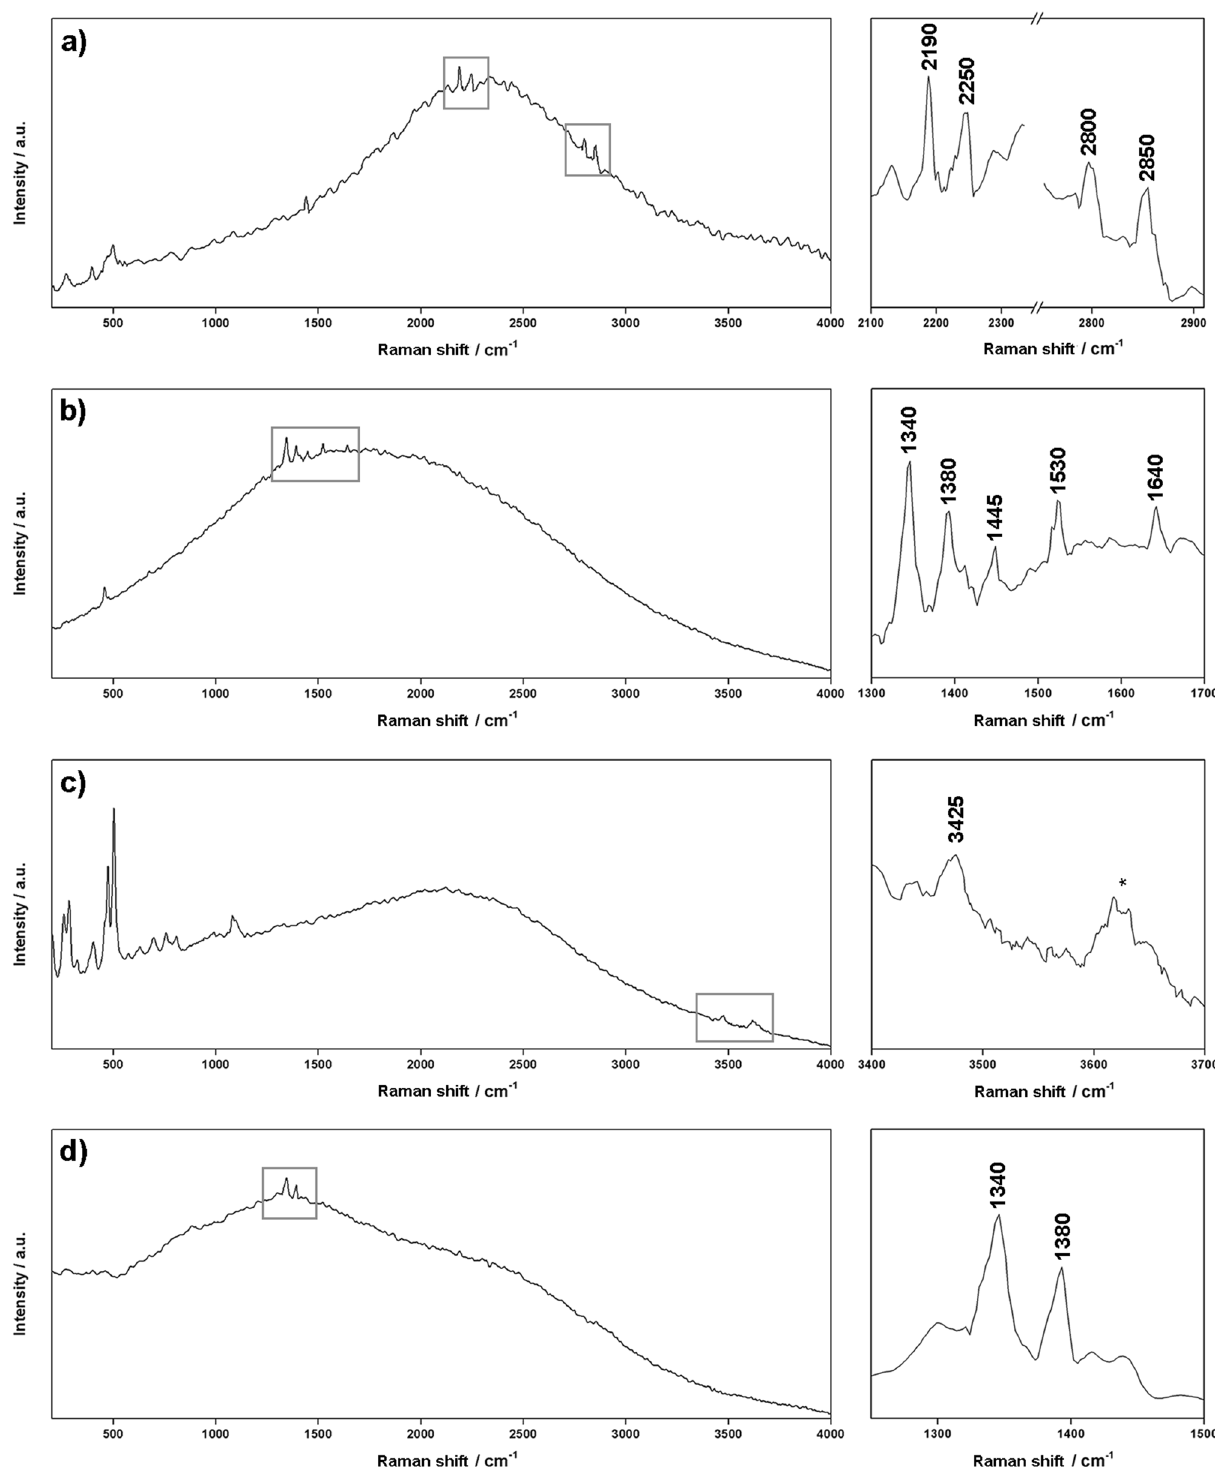
Figure 2. Characteristic Raman spectra of organic compounds collected in the laboratory by the RLS ExoMars Simulator (532 nm). All spectra have been smoothed using dedicated IDAT/SpectPro